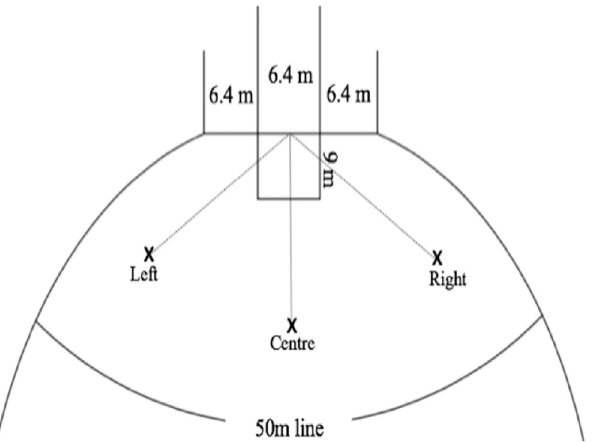
Fig 1. Schematic of the experimental set-up; each kicking position was 30 m from the goal and kicks taken at the right and left positions were at a 45-degree angle to the goal. Goal-kicking positions were representative of typical positions used in competition (as identified by Champion Data from the 2017 AFL